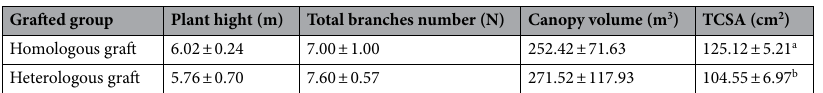
Table 1. The phenotype of scions in two grafted groups 10 years after graft. A significant difference between graft groups was indicated by different lowercase letters ( P < 0.05) using the Student’ s t-test, no letter represent no difference. Values are means ±